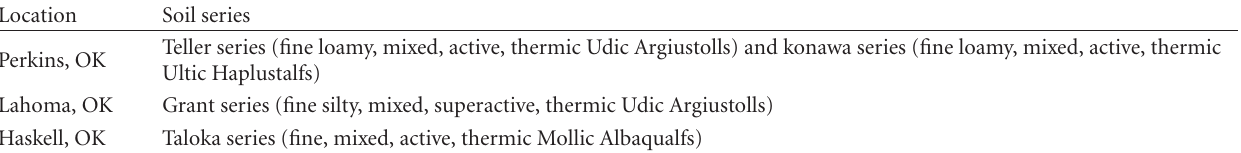
Table 1: Description of soil series at Perkins, Lahoma, and Haskell,